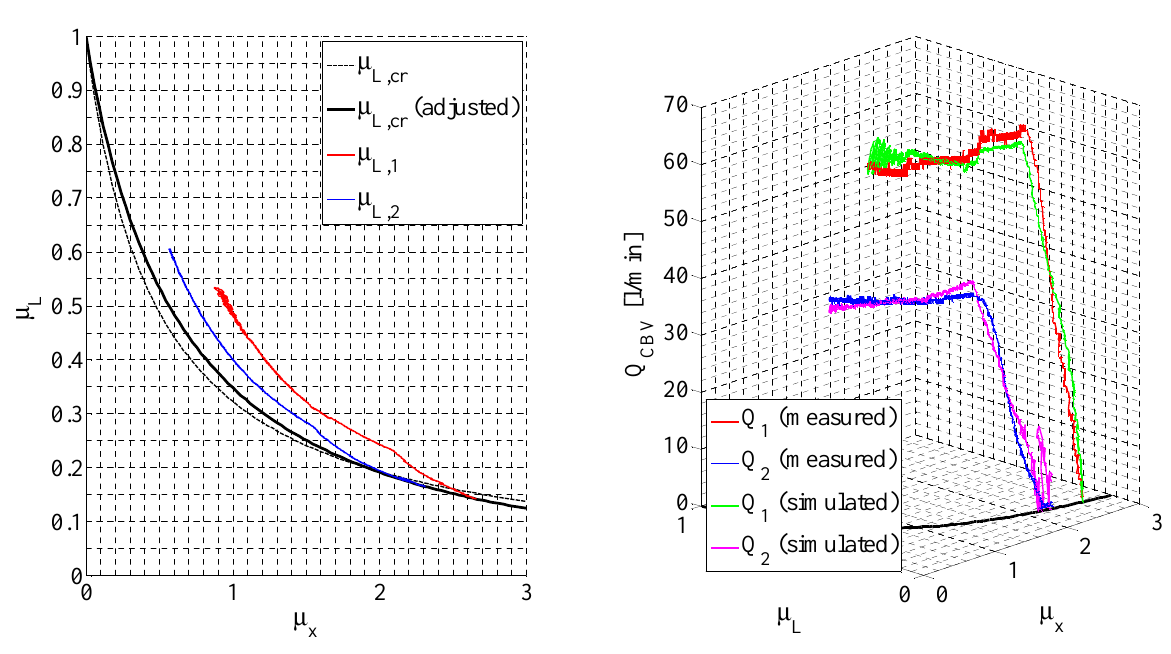
Figure 15: Relation between µ L and µ x for the outer jib CBVs.